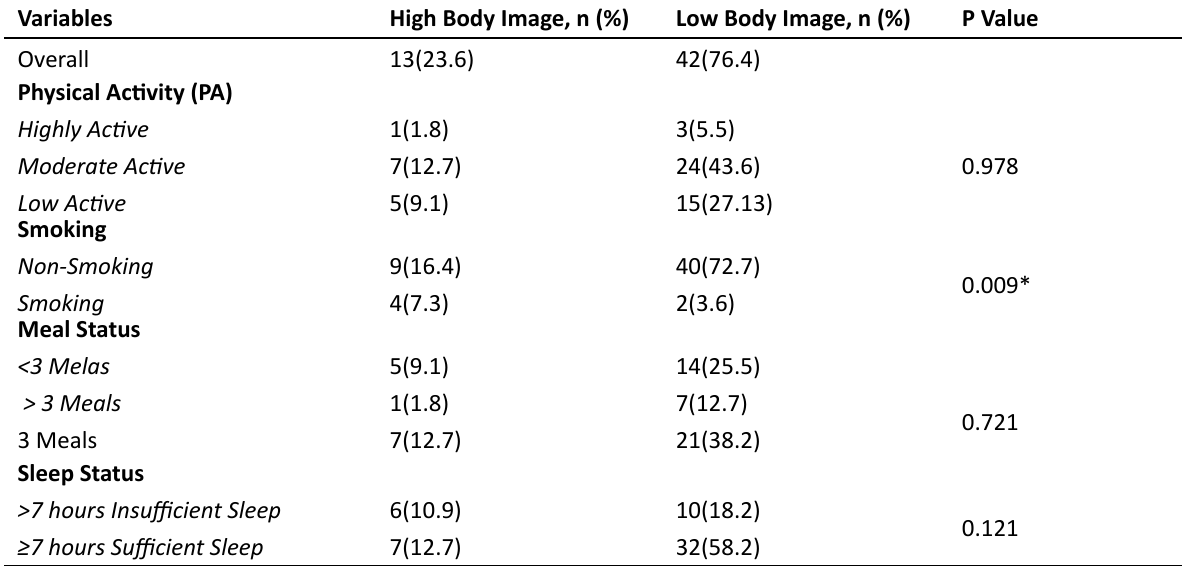
Table 3. Association of Physical Activity, Sleep, Meal Status and Smoking with Body Image (Chi Square)